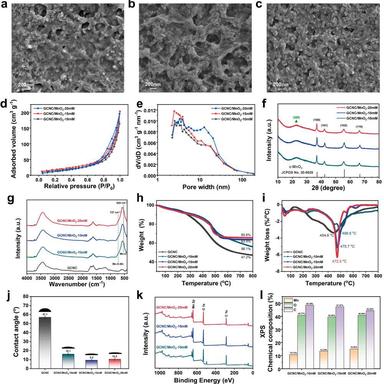
SEM images of (a) GCNC/MnO2-10 mM, (b) GCNC/MnO2-15 mM, and (c) GCNC/MnO2-20 mM. (d) N2 adsorption/desorption isotherms, (e) pore size distribution, and (f) XRD patterns of heterostructural GCNC/MnO2. (g) FTIR spectra, (h) TGA curves, (i) DTG curves, and (j) water contact angle of GCNC and GCNC/ MnO2. (k) XPS survey spectra of GCNC/MnO2. (l) Percentage of C, O, and Mn elements in different samples from XPS results.